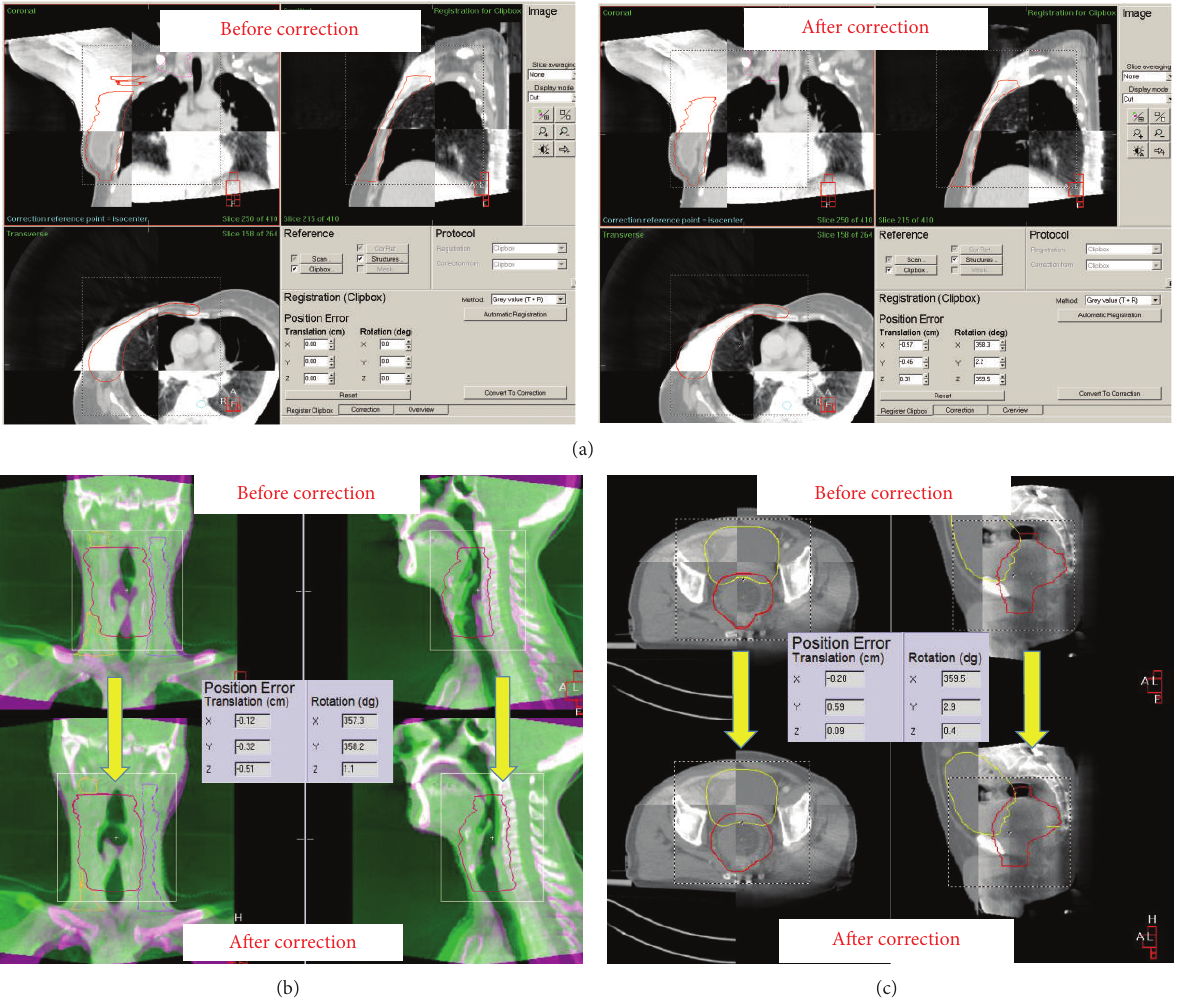
Figure 2: KV CBCT volumetric imaging. Both translational and rotational errors may be estimated. Translational errors are easily corrected whereas few systems have provisions for correcting rotational errors with couch rotations. (a) CBCT compared with reference scan before and after correction of setup error in a case of Carcinoma right breast, post-mastectomy. (b) CBCT correction in a case of Carcinoma larynx. (c) CBCT in a case of Carcinoma prostate not only corrects for setup errors, but also provides an estimate of reproducibility of prostate position with respect to bladder filling. In this particular case, the live image shows negligible bladder filling and treatment was delayed to allow for optimum bladder position for obtaining a reproducible position of prostate as well as moving the bowel out of treatment field. KV: kilovoltage; CBCT: cone beam computed